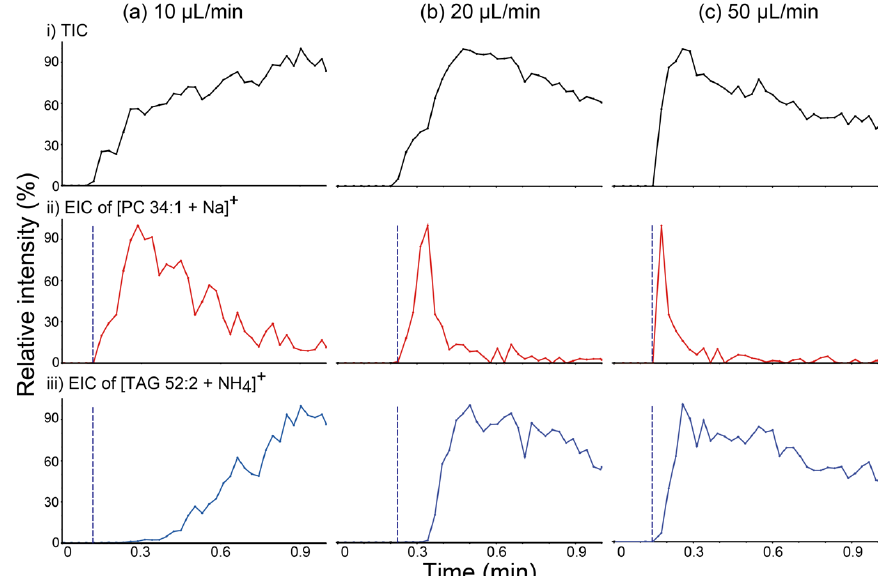
Figure 4. ( a – c ) (i) Total ion chronograms (TICs) of paper spray ionization mass spectrometry (PSI MS) analysis of a beef lipid extract and extracted ion chronograms (EICs) for (ii) the [PC 34:1 + Na] + ion at m/z 782.8 and (iii) the [TAG 52:2 + NH 4 ] + ion at m/z 876.8. PSI MS analyses were performed implementing the wicking mode for solvent application at various solvent feeding rates: ( a ) 10, ( b ) 20, and ( c ) 50 µL/min. Blue dashed lines were inserted into EICs for comparing the detection times of lipids belonging to the phosphatidylcholine (PC) and triacylglycerol (TAG) classes. PC 34:1: phosphatidylcholine 34:1; TAG 52:2: 1,3-dioleyl-2-palmitoyl-glycerol. Molecules 2021 , 26 , x FOR PEER REVIEW